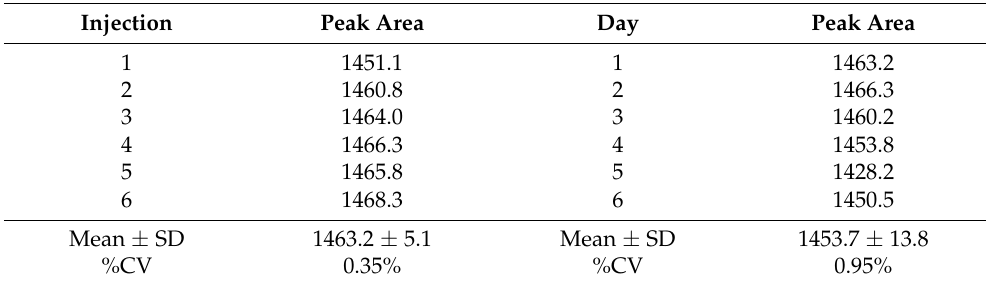
Table 1. Intra-day and inter-day precision of replicate injections of 100 mg L − 1 tebuthiuron standards analyzed using the HPLC method.